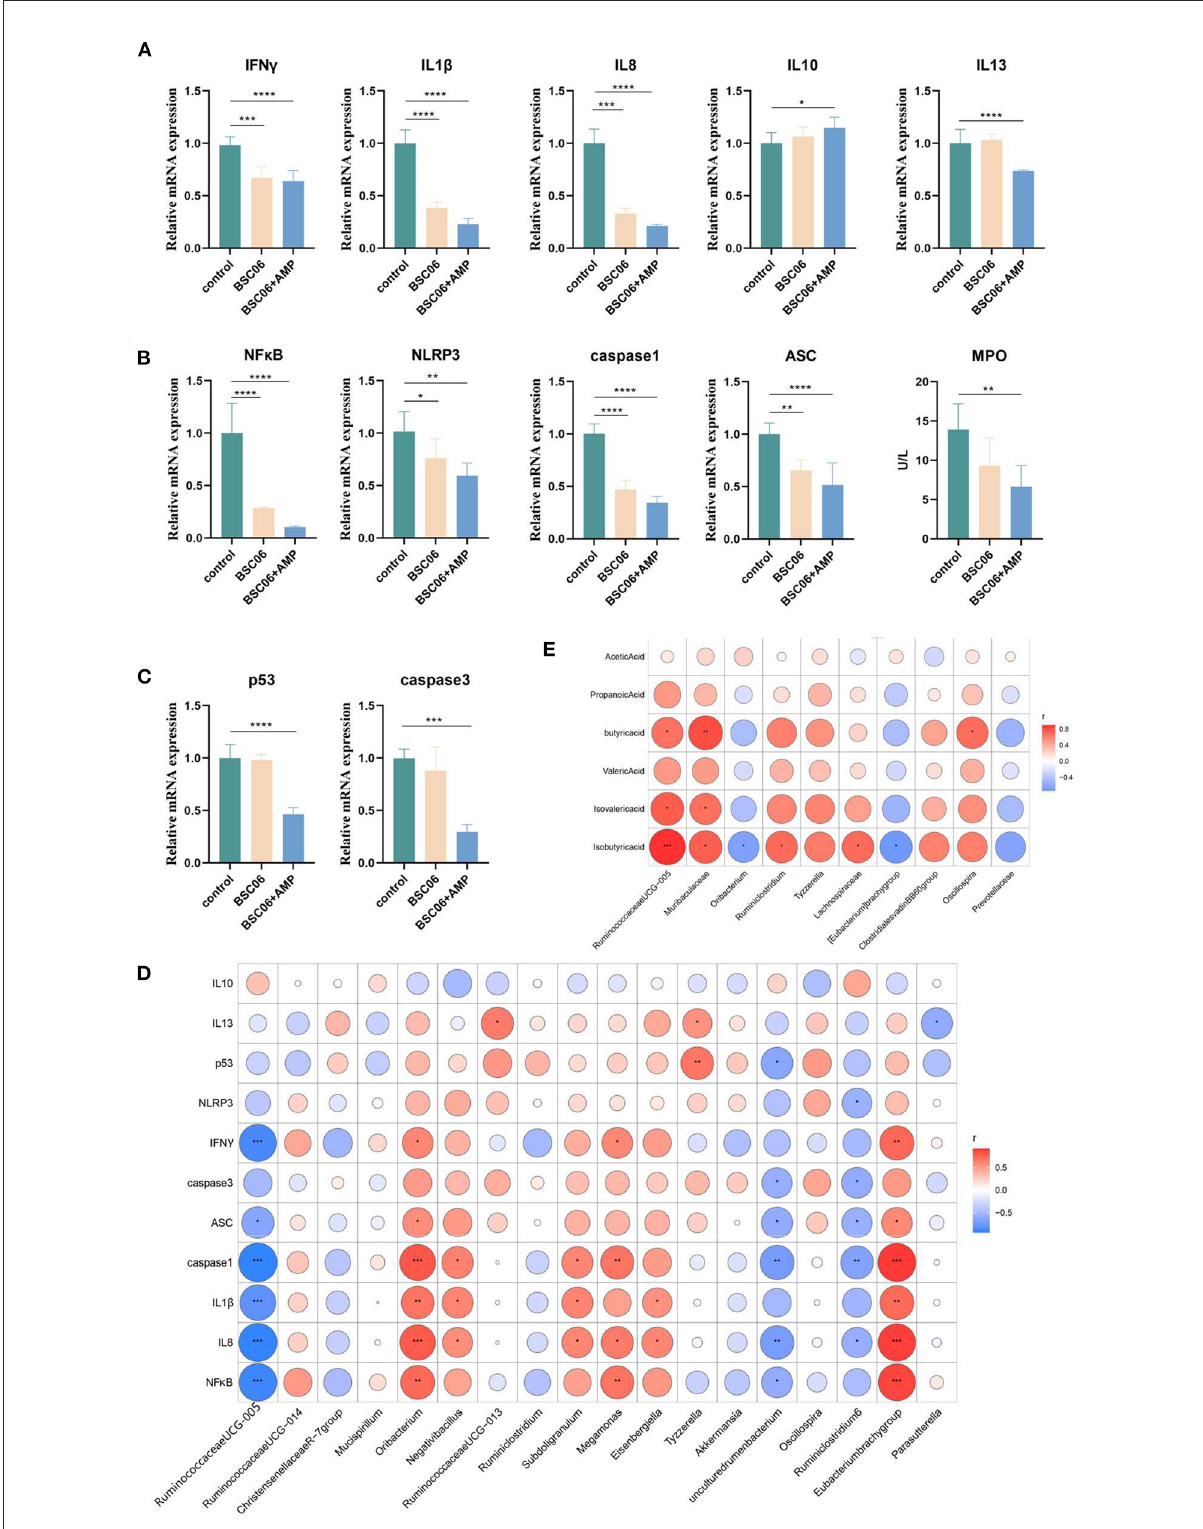
FIGURE9 Correlation between expression of inflammation and apoptosis related genes and differential bacteria. (A) Relative mRNA expression of cytokines. (B) Relative levels of canonical activation of the inflammasome related mRNA. (C) Relative mRNA expression of critical proteins for apoptosis. (D) Pearson’s correlation analysis of differential genus and gene expression. (E) Pearson’s correlation analysis of differential genus and short-chain fatty acid. * P < 0.05, ** P < 0.01, *** P < 0.001, **** P <